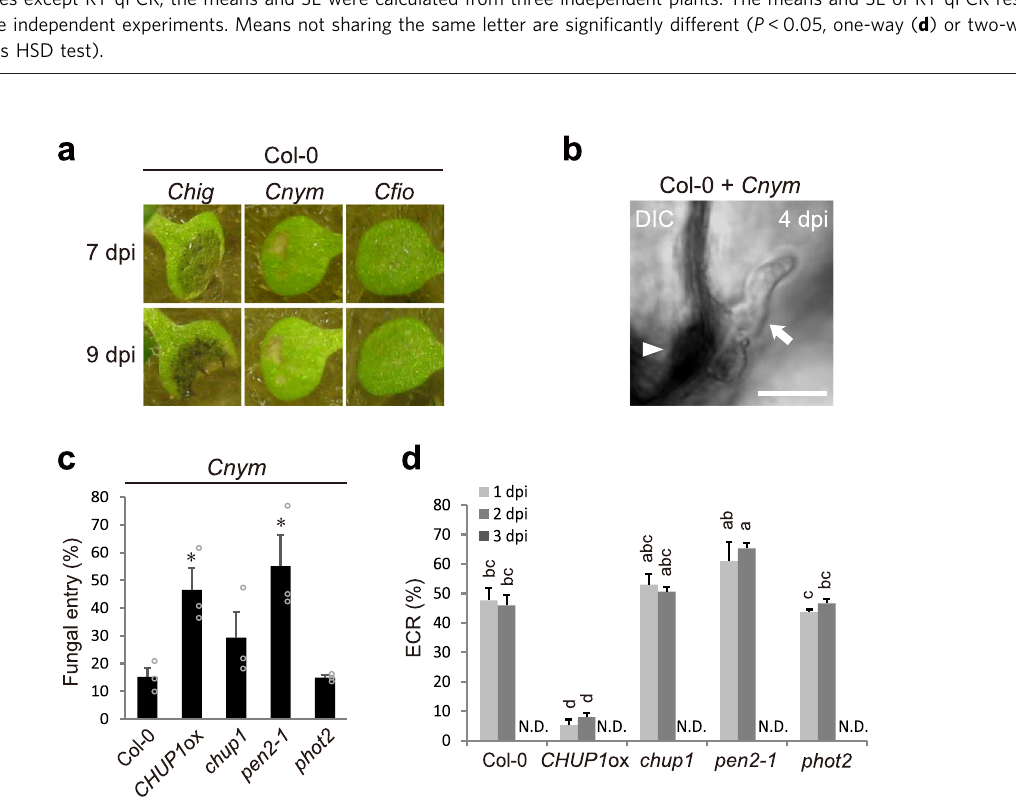
Fig. 7 Epidermal chloroplast-localized immune components are critical for preinvasive NHR against Colletotrichum fungi. a Fungal entry rate into Arabidopsis epidermis. C fi o , Csia , and Corb were inoculated onto cotyledons of the indicated Arabidopsis . b Induced gene expression of PAD3 , CYP79B2 , PDF1.2a , PR1 , FRK1 , and NHL10 by inoculation of C fi o . C fi o was inoculated onto cotyledons of the indicated Arabidopsis , and gene expression was assayed at 24 hpi by RT-qPCR. DW was used as a control. c , d Invasions of Corb and Csia (low-invasive strain) into Arabidopsis epidermis at 4 dpi. Corb and Csia (low- invasive strain) were inoculated onto cotyledons of the indicated Arabidopsis with multiple mutations. The arrowheads and arrows indicate melanized appressoria and invasive hyphae, respectively. Scale bar, 10 µ m. For quanti fi cation of fungal entry of C fi o , Csia , and Corb , 100 melanized appressoria were investigated at 4 dpi. For quanti fi cation of fungal entry of Csia (low-invasive strain), 300 melanized appressoria were investigated at 4 dpi. For all